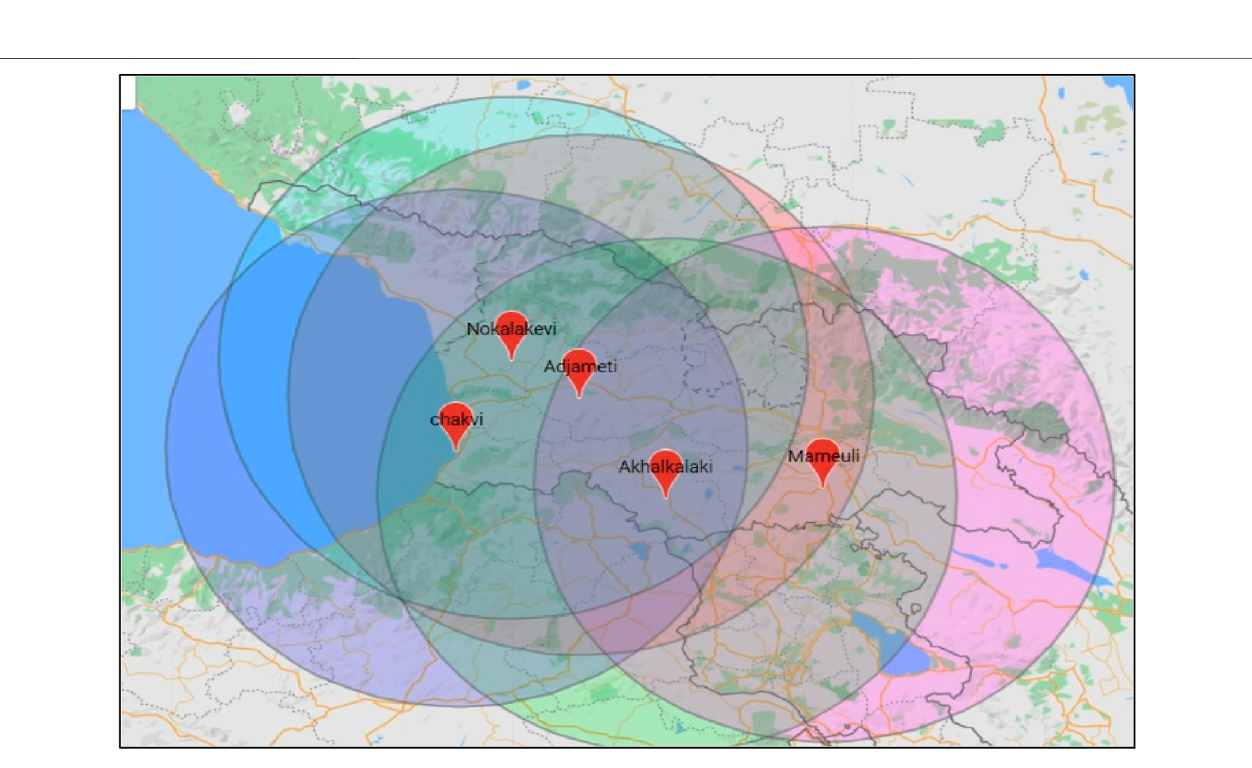
FIGURE 3 | Map of fi ve separate circular regions around wells with water-level